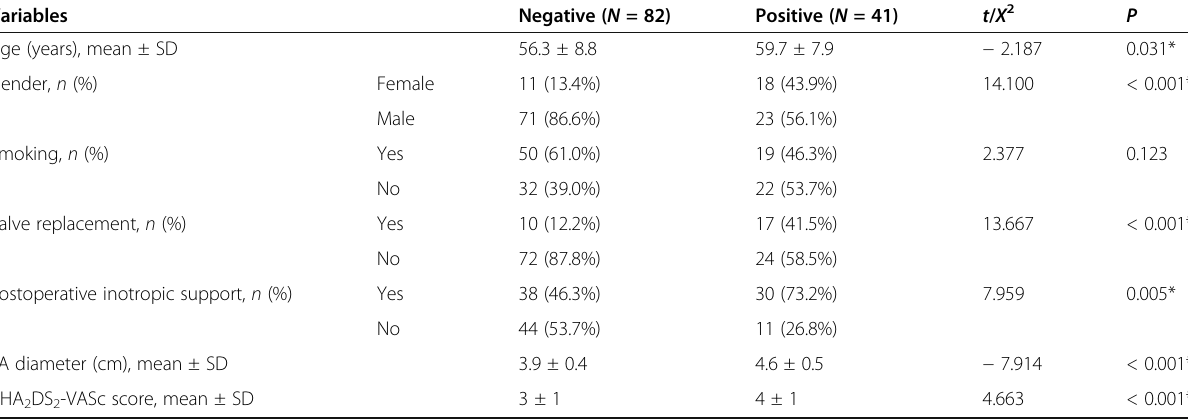
Table 1 The association between postoperative atrial fibrillation and patients ’ characteristics